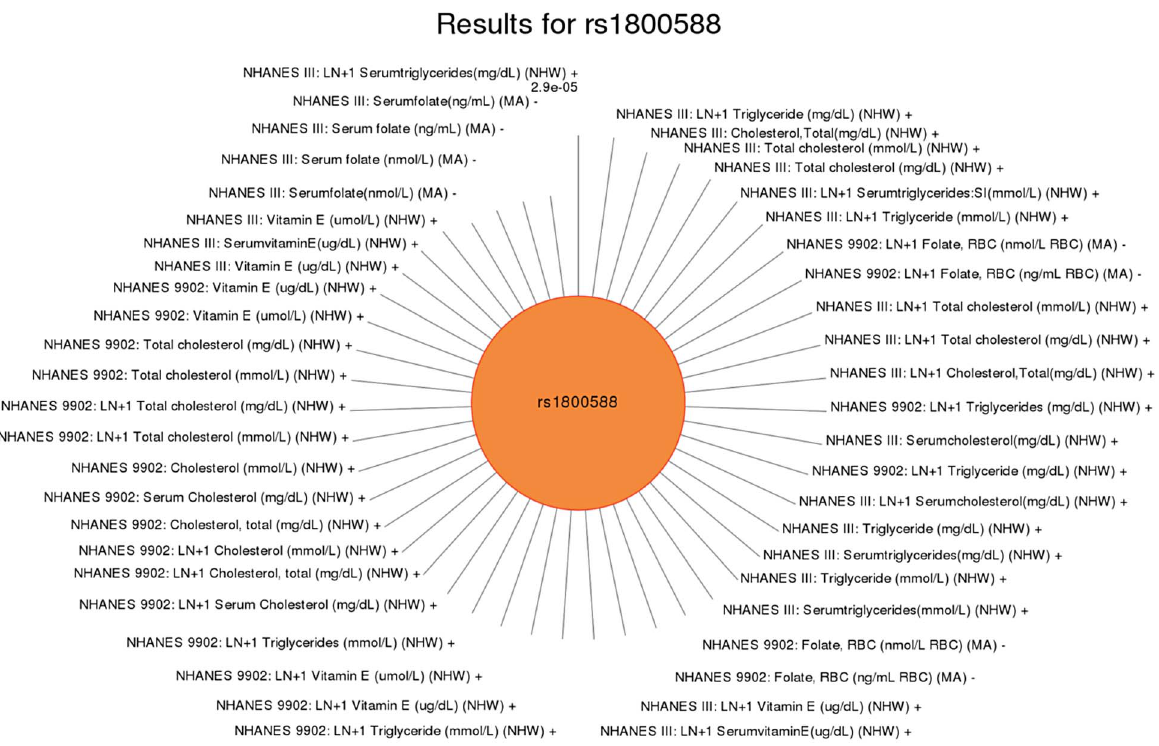
Fig. 7. Sun plot of (p , 0.01) results for LIPC rs1800588, coded allele T. This SNP was previously associated HDL-C in European-descent populations. Significant associations (p , 0.01) are plotted clockwise with the most significant value result at the top. The length of the each line corresponds to the –log(p-value) of each result, with the longest line representing the most significant result for this SNP, meeting our PheWAS replication criteria for inclusion. Study, transformed (LN + 1) or untransformed (none) phenotype description, self-reported race-ethnicity, and direction of effect are listed for each association. This SNP was associated with a number of phenotypes including folate in Mexican Americans (MA), total cholesterol in non-Hispanic whites (NHW), triglyceride levels in non-Hispanic whites, and vitamin E levels in non-Hispanic